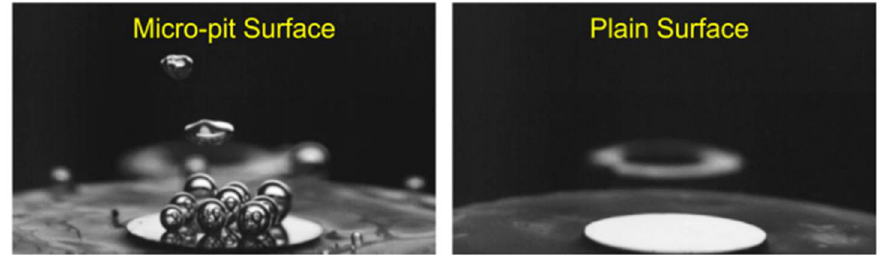
Figure 22. Boiling images on the micro-pit surface and plain surface with the heat flux of 3 W/cm 2 . Reprinted with permission from Ref [113]. Copyright 2020 Elsevier.